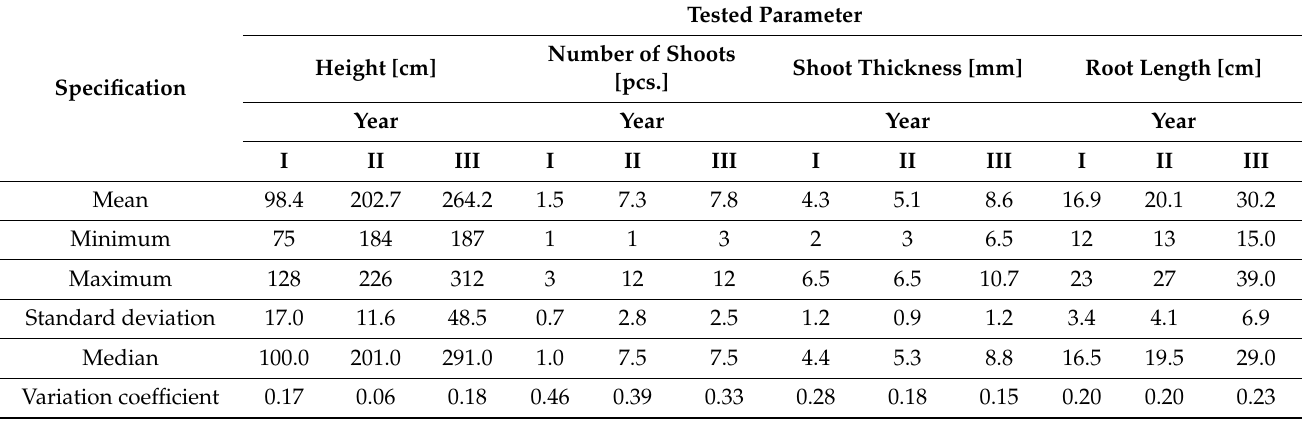
Table 3. Biometric parameters of a giant